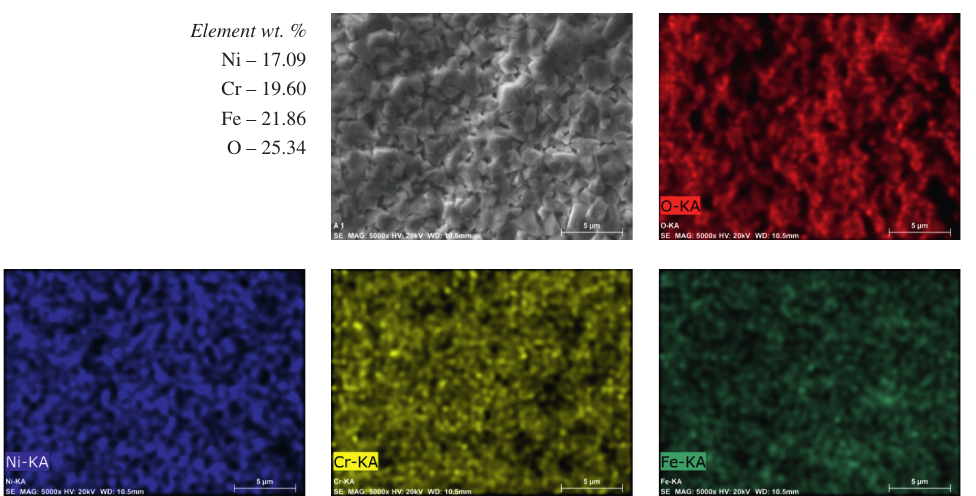
Figure 12: SEM, EDS and image mapping of the exposed sample after removal of oxides.